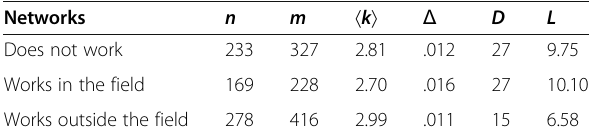
Table 1 Macrostructural data of the giant component of critical